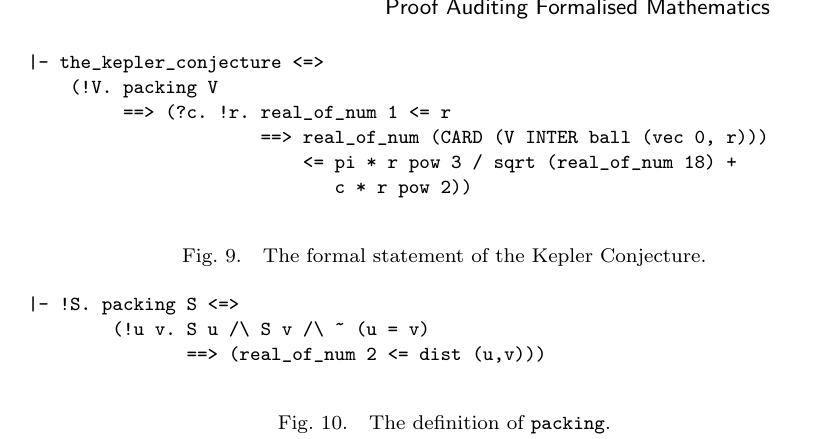
Fig. 9. The formal statement of the Kepler Conjecture.